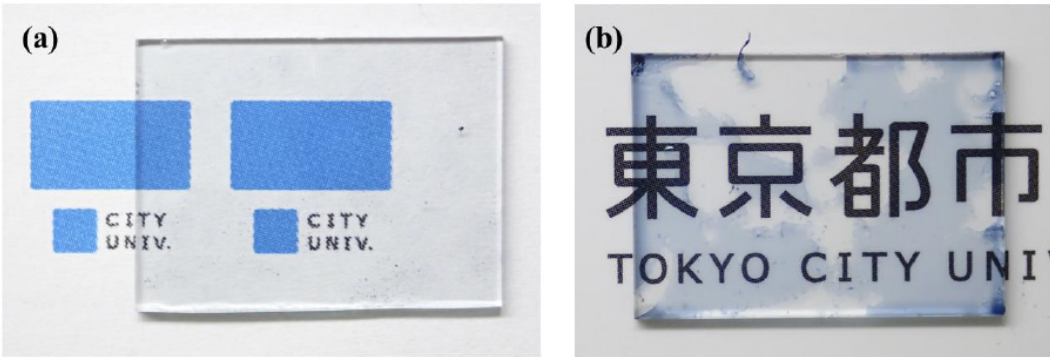
Figure 3. Appearance of ( a ) the PEDOT / PEB sample and ( b ) commercial PEDOT / PSS film after ultrasonic treatment in water. The conventional PEDOT / PSS film peeled o ff heterogeneously other than the PEDOT / PEB sample.